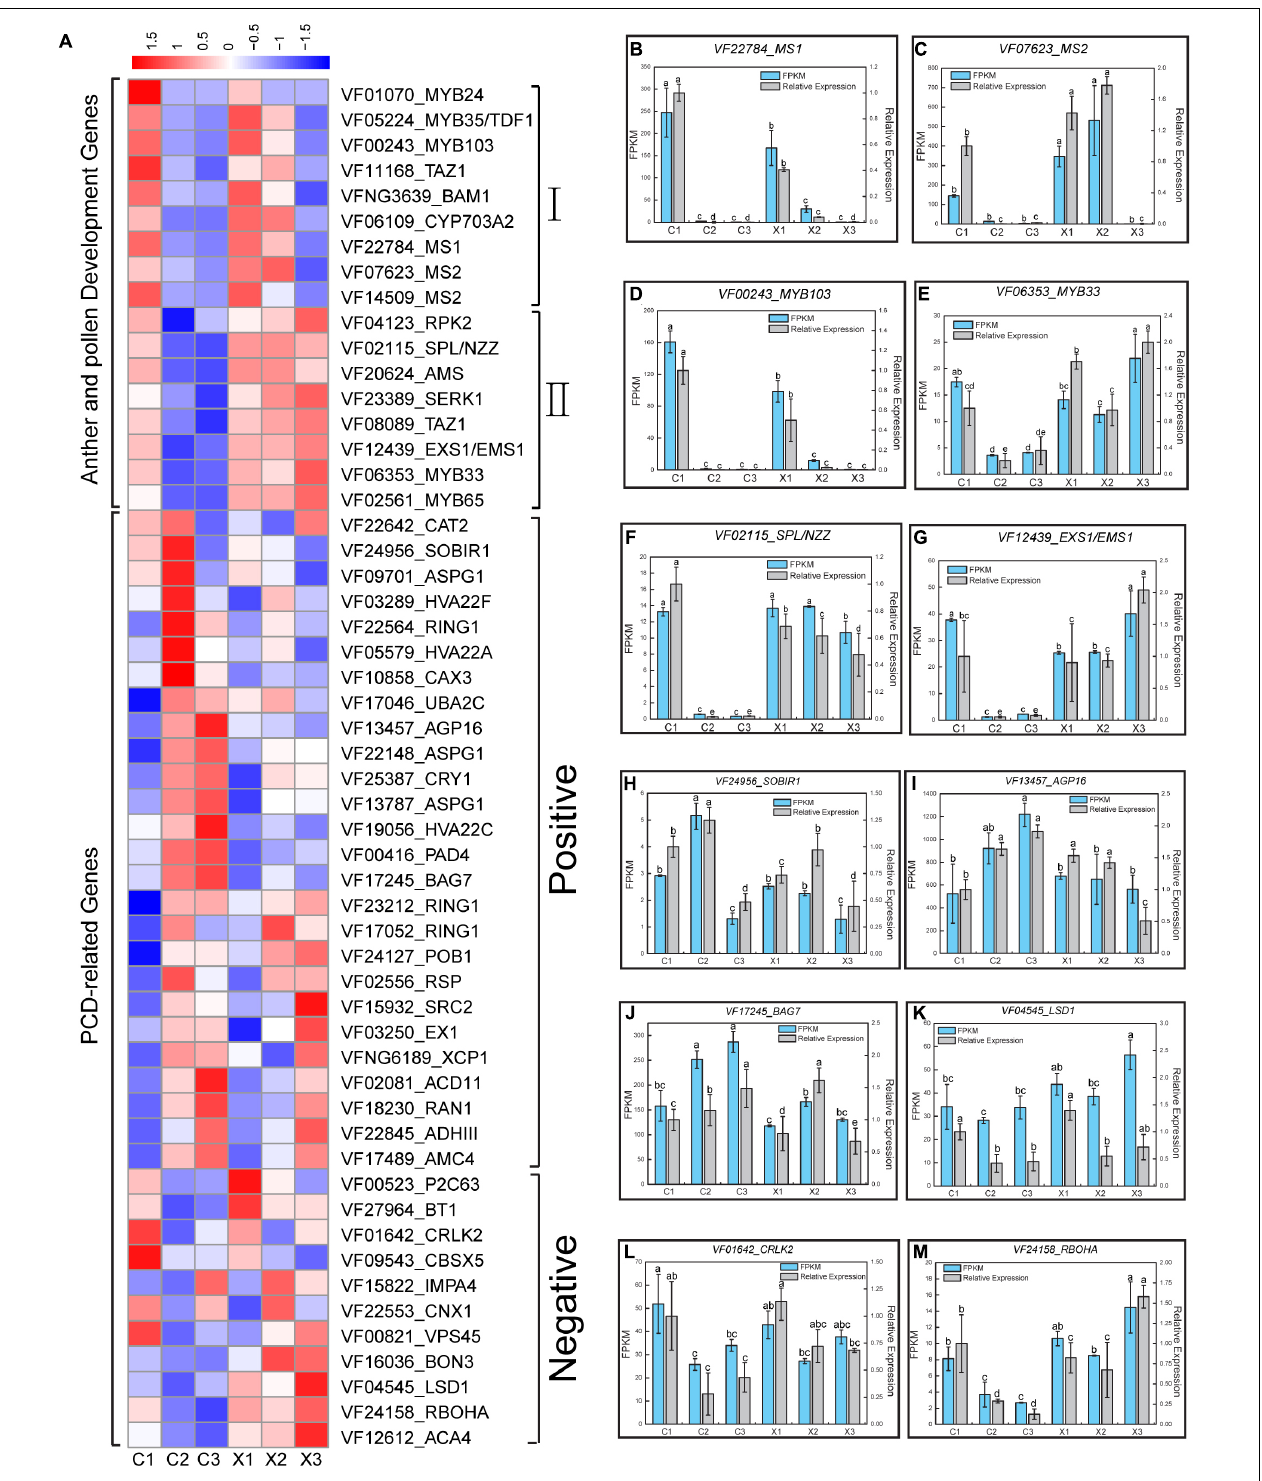
FIGURE 4 | Expression patterns of anther and pollen development genes and PCD-related genes in male and female flowers. (A) Heatmap analysis of the important anther and pollen development genes and PCD-related genes in male and female flowers; I, Genes highly expressed in C1, X1, and X2; II, Genes highly express in C1, X1, X2, and X3. (B–G) Expression levels of MS1 , MS2 , MYB103 , MYB33 , SPL/NZZ , and EXS1/EMS1 based on FPKM and qRT-PCR data. (H–M) Expression levels of SORB1 , AGP16 , BAG7 , LSD1 , SRLK2 , and ROHBA based on FPKM and qRT-PCR data. Error bars indicate SD. Different letters represent significant difference in mRNA levels ( p <